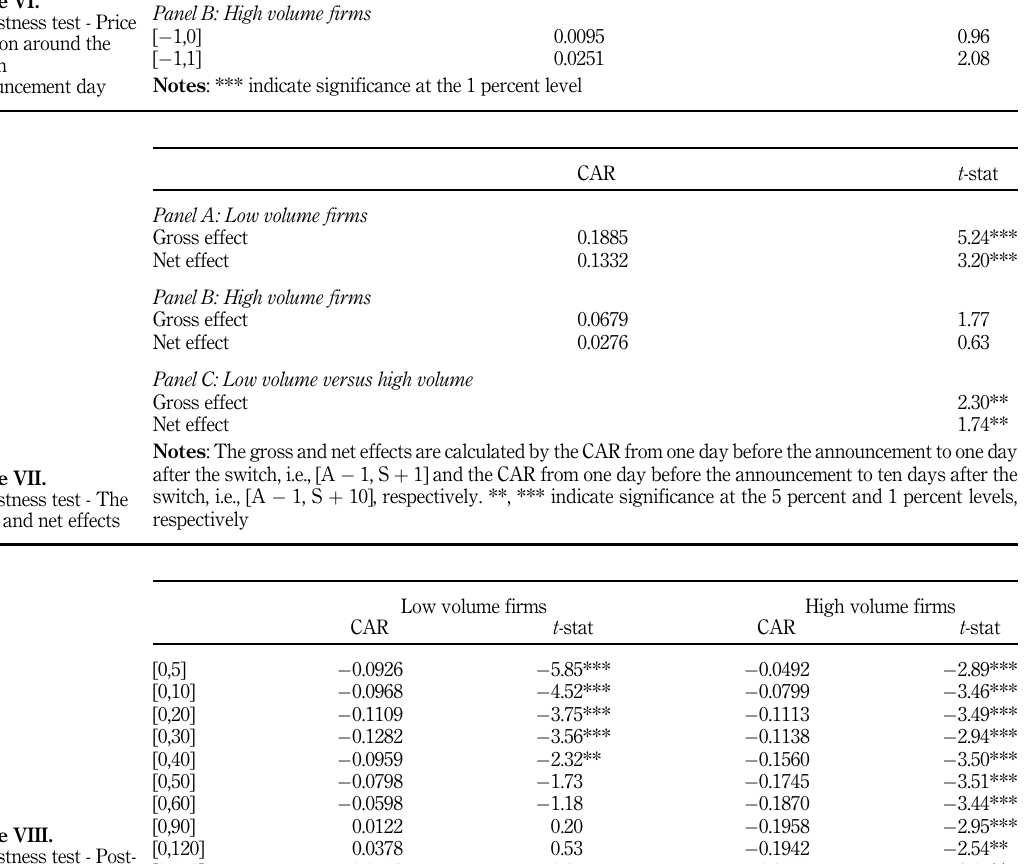
Table VIII. Robustness test - Post- switching CARs after moving to the